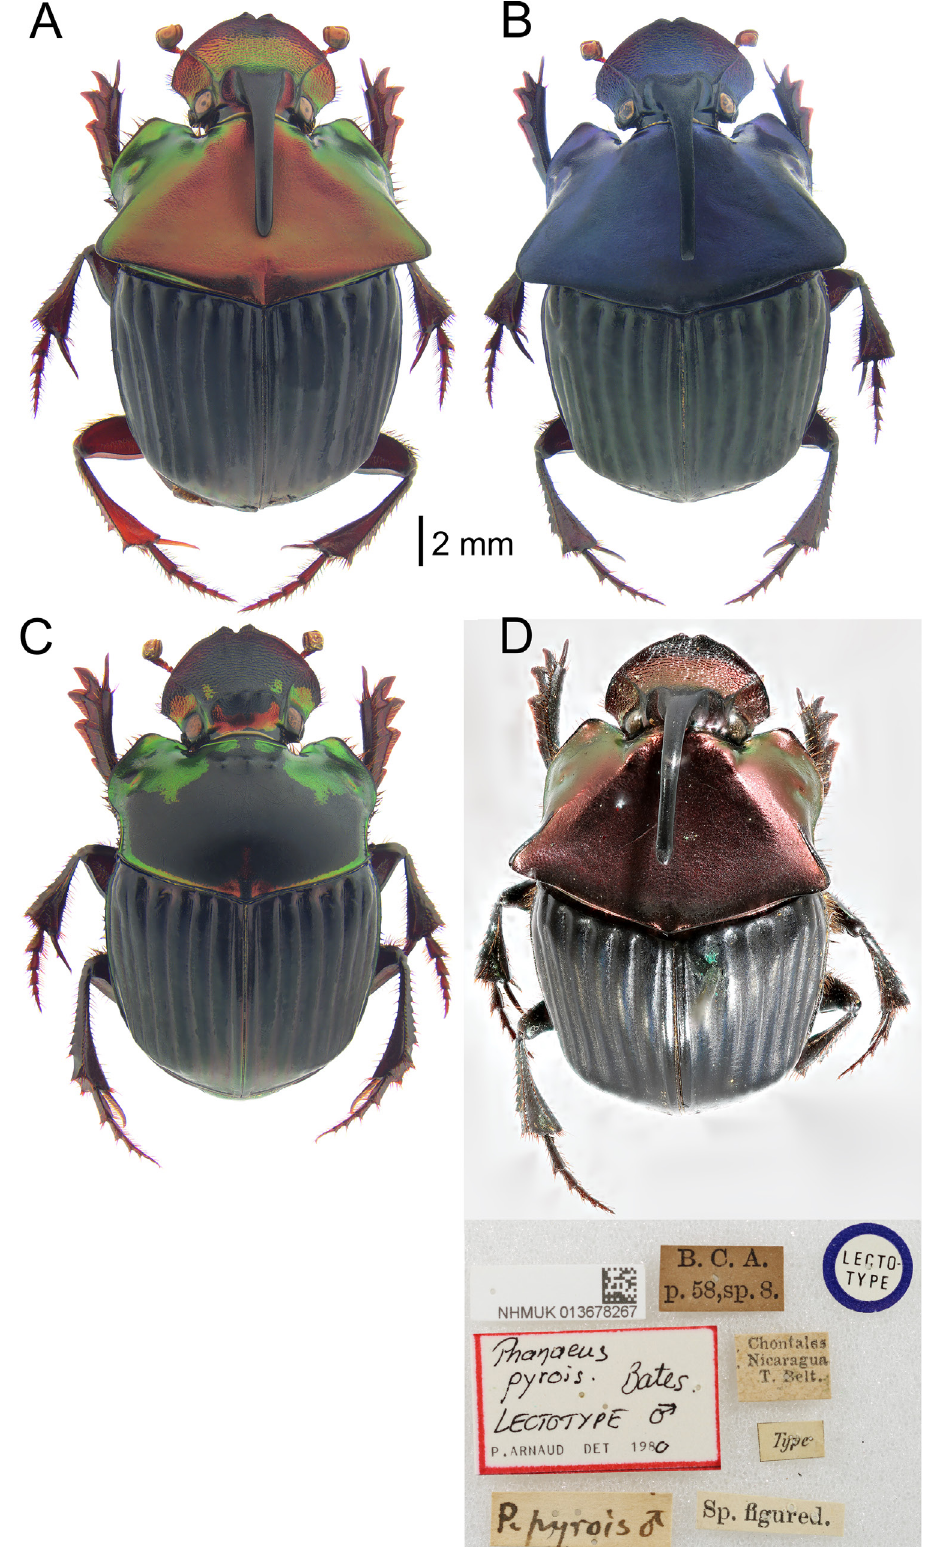
Fig. 12. Phanaeus pyrois Bates, 1887. A . ♂, red morph (VCM). B . ♂, blue morph (VMC). C . ♀, green morph (TAMU). D . Lectotype, ♂ (by Mario Cupello, Universidade Federal do Paraná, Brazil)